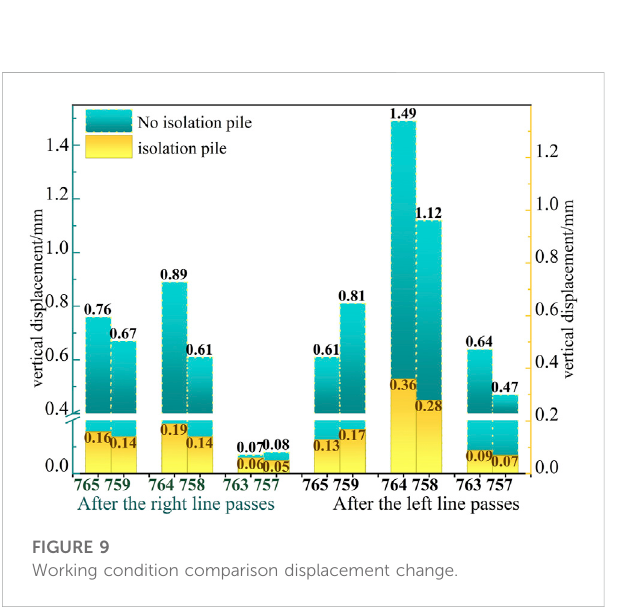
FIGURE 9 Working condition comparison displacement change.